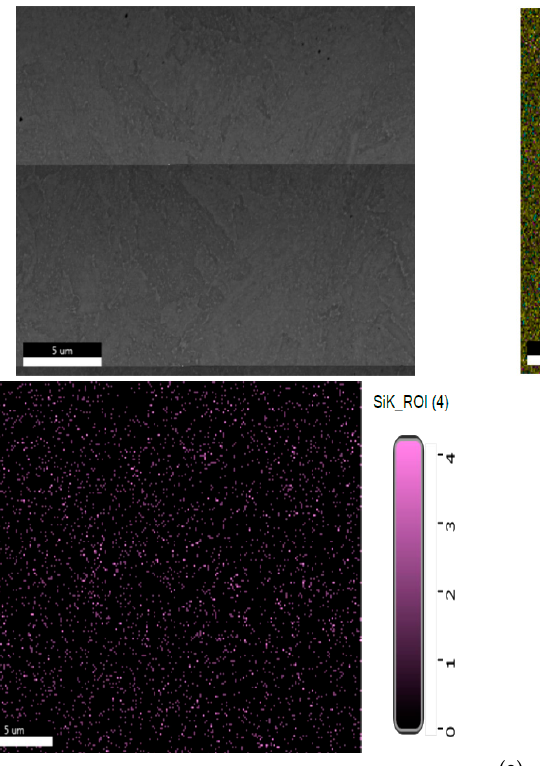
Figure 9. Electronic scanning microscopy for 25CrMo4 steel sample. Optical microscopy studies provide a sequence of data that attests to the influence of the chemical composition of steel on the structure, as well as the changes generated by thermal treatments. Results obtained for structural investigation of energy dispersion spectrometry (EDS, are presented in Figure 10.